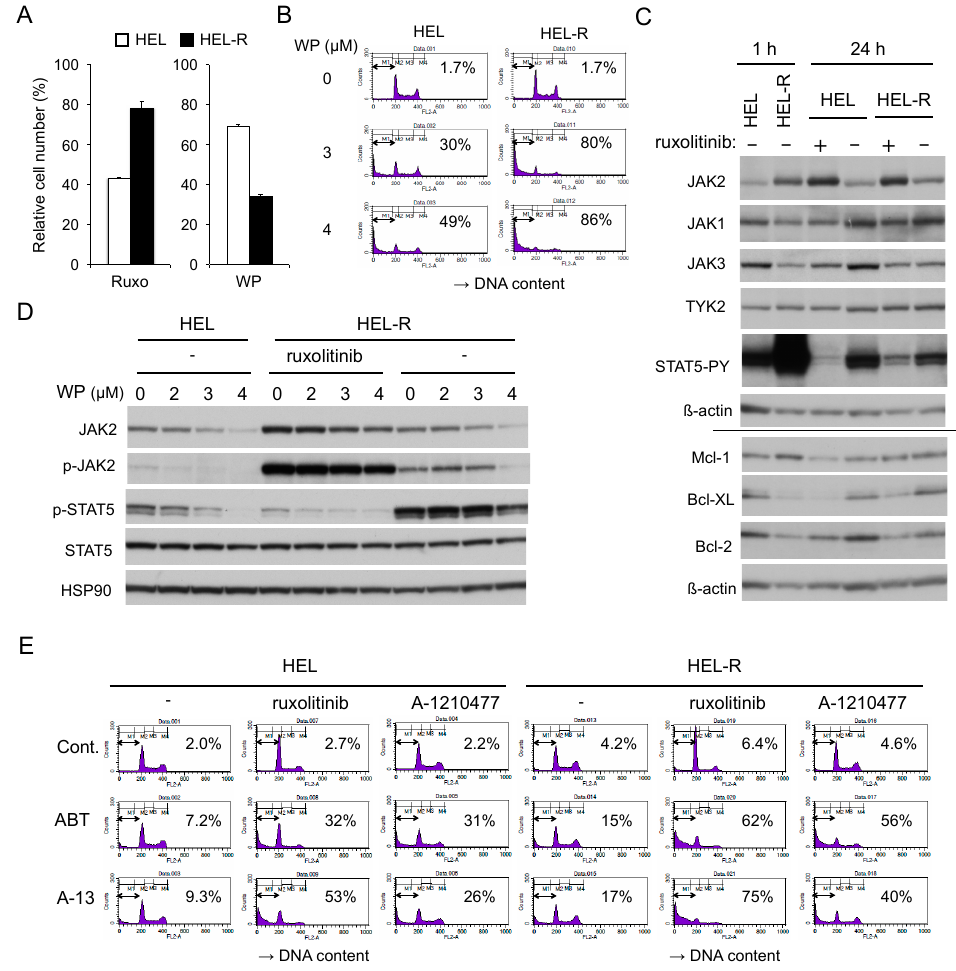
Figure 6. Ruxolitinib-persistent HEL-R cells exhibit an increased sensitivity to WP1130 or BH3 mimetics as compared with control HEL cells. ( A ) HEL or ruxolitinib-persistent HEL-R cells were left untreated as control or treated with 1 µ M ruxolitinib for 48 h or with 2 µ M WP1130 for 24 h. Viable cell numbers were measured by the CCK-8 colorimetric assay. Each column represents the mean of triplicate cultures, with error bars indicating standard errors, and is expressed as a ratio to the control. ( B ) HEL or HEL-R cells were treated with indicated concentrations of WP1130 for 24 h. Cells were analyzed for DNA content by flow cytometry. Percentages of apoptotic cells with the sub-G1 DNA content are indicated. ( C ) HEL or HEL-R cells were washed and cultured with or without 1 µ M ruxolitinib for indicated times and lysed for immunoblot analysis with antibodies against indicated proteins. The results obtained from duplicate gels are shown above or below a horizontal line. ß-actin was used for a loading control. ( D ) HEL or HEL-R cells were treated for 3 h with indicated concentrations of WP1130 with or without 1 µ M ruxolitinib, as indicated, and analyzed. HSP90 was used for a loading control. ( E ) HEL or HEL-R cells were left untreated as control or treated for 40 h with 1 µ M ABT-737 (ABT), 5 nM A-1331852 (A-13), 1 µ M ruxolitinib, or 5 µ M A-1210477, as indicated, and analyzed.